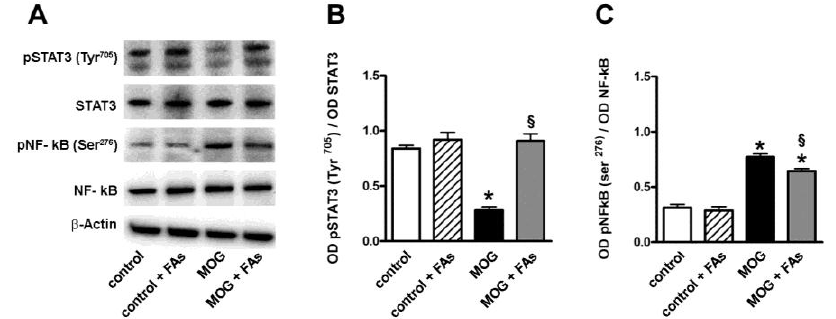
Figure 2. Dietary supplementation with FAs prevents MOG-induced downregulation of signal transducer and activator of transcription 3 (STAT3) phosphorylation and reduces upregulated levels of phosphorylated nuclear factor kappa-light-chain-enhancer of activated B cells (NF-κB). ( A ) Representative blots from retinal homogenates of control and MOG-treated mice, with or without FAs supplementation. Protein levels of pSTAT3 (Tyr 205 ) ( B ) and pNF-κB (Ser 276 ) ( C ) were evaluated by Western blot using STAT3 or NF-κB as loading controls. Data from densitometric analysis are shown as the mean ± S.E.M. ( n = 9 for each experimental group). * p < 0.001 versus control. § p < 0.001 versus MOG (One way ANOVA followed by the Newman–Keuls multiple comparison post-hoc test). White bars, control mice; dashed bars, control mice with FAs supplementation; black bars, MOG-treated mice; grey bars, MOG-treated mice with FAs supplementation.